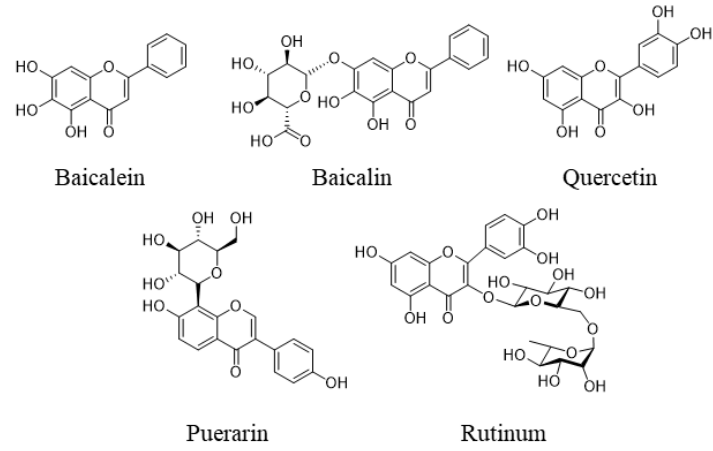
Figure 1. Structural formulas of five flavonoids used in the experiment.